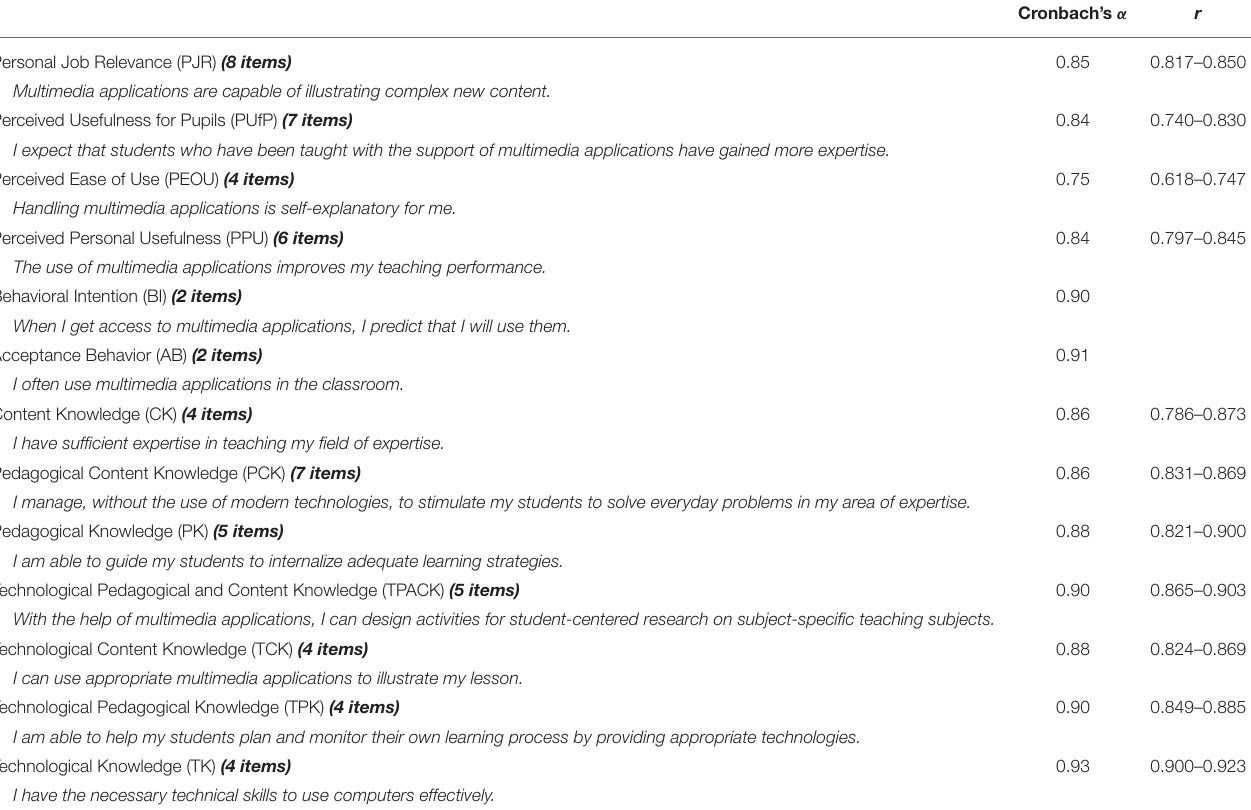
TABLE 1 | Instrument—overview with example